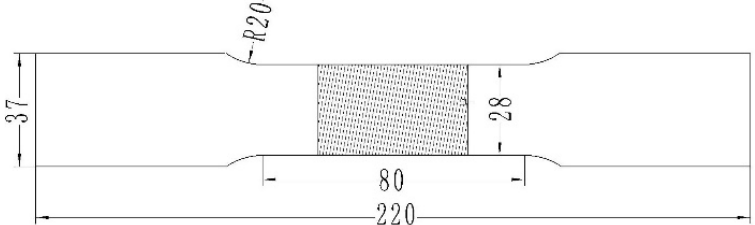
Figure 3. The sampling position of each specimen is shown in Figure 4.